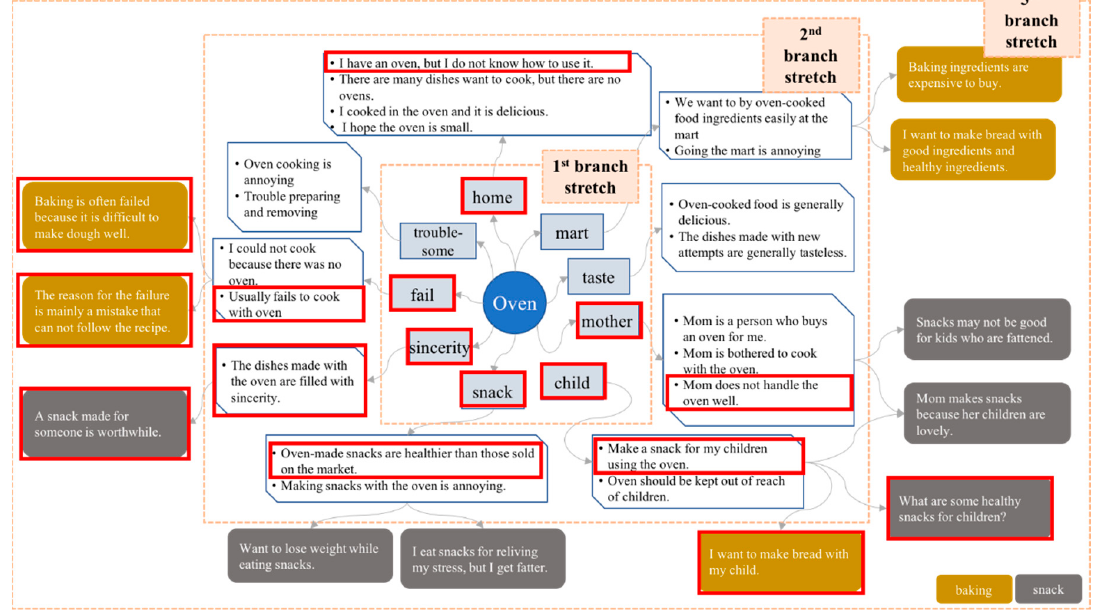
Figure 10. User contexts targeted by scenario ‘Oven never fail to cook!’